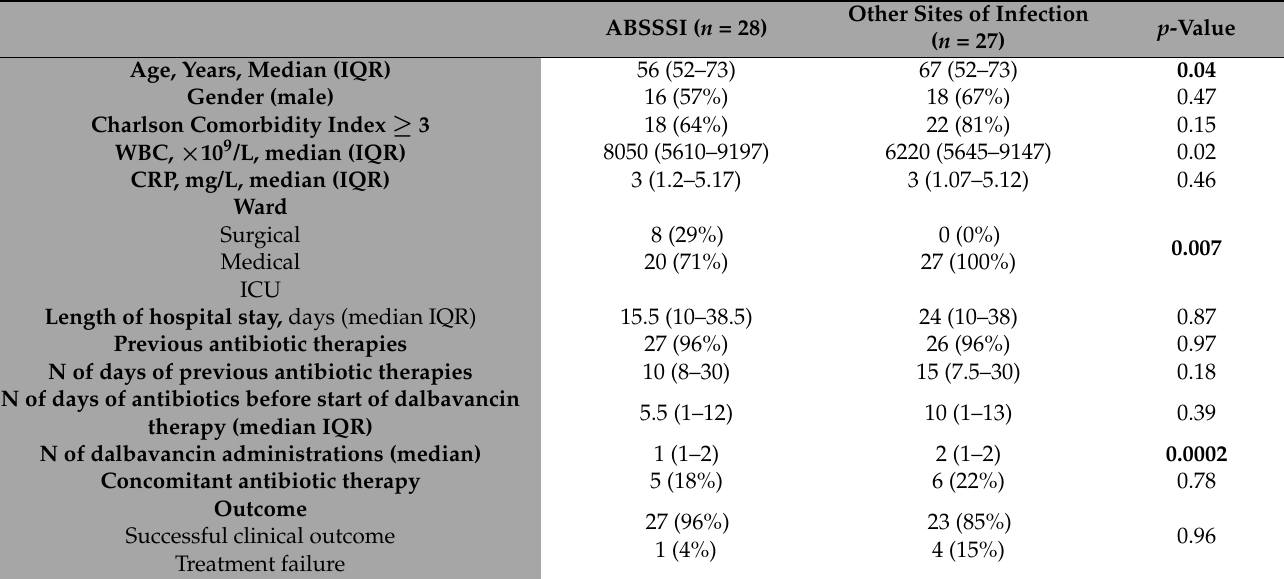
Table 4. Comparison of patients’ characteristics between the acute bacterial skin and skin structure infections (ABSSSI) group and the non-ABSSSI